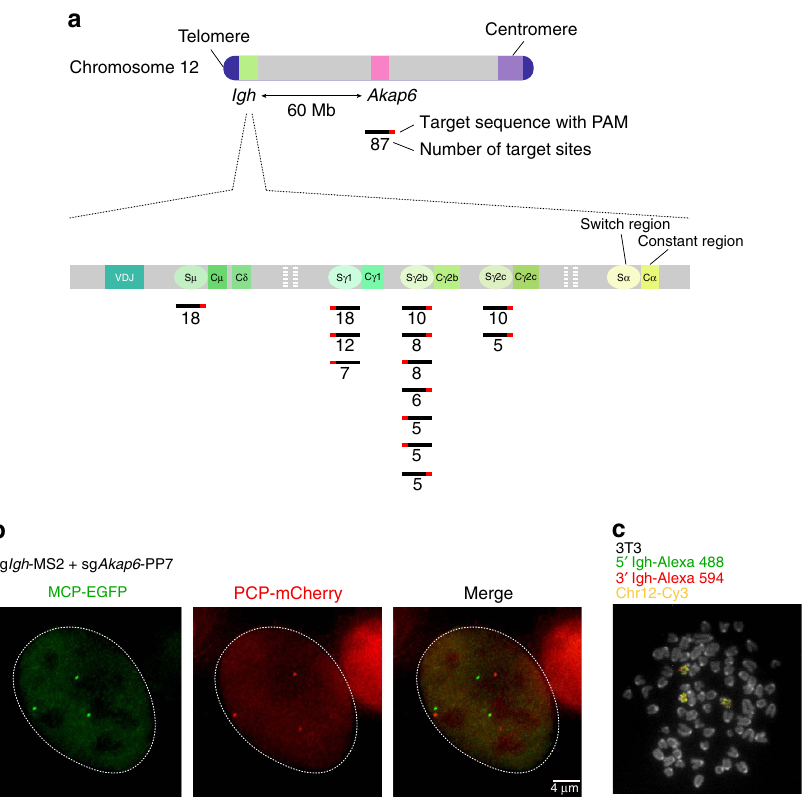
Figure 4 | Imaging of single loci on the mouse chromosome 12. ( a ) Scheme of sgRNAs designed to target Igh and Akap6 on mouse chromosome 12. A single sgRNA targets 87 locations on the Akap6 gene across 6.2kb. Thirteen different sgRNAs were designed to target four different Igh switch regions at the telomeric end of mouse chromosome 12. The number of hits for each sgRNA is written below the bar representing its location ( b ) 3T3 fibroblasts expressing dCas9, MCP-EGFP and PCP-mCherry were co-infected with virus targeting the Akap6 gene (sg Akap6 -PP7) and the 4 Igh switch regions (sg Igh -MS2). ( c ) Cytogenetic analysis of chromosome 12 and Igh on 3T3 fibroblasts using metaphase-FISH with a mouse chromosome 12 paint and 2 BAC probes surrounding Igh (Igh 5 0 and Igh 3 0